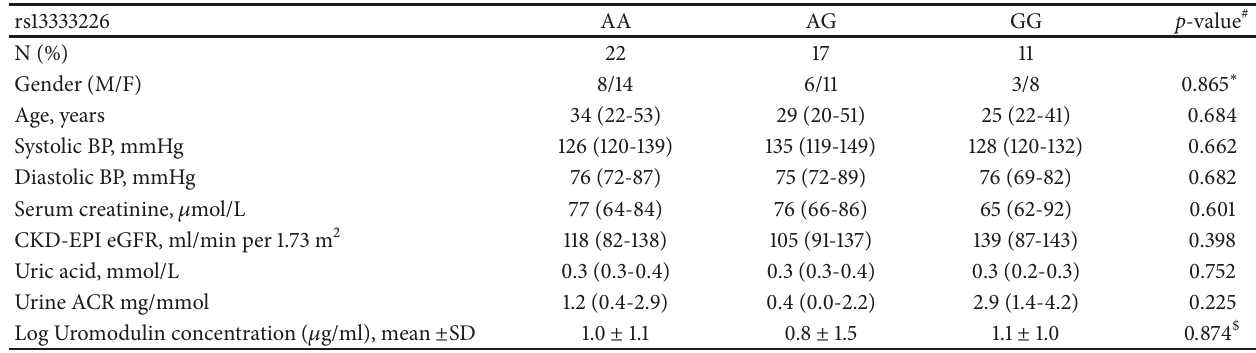
Table 4: Relationship between rs13333226 polymorphisms in the UMOD gene and clinical and demographic features in first-degree relatives.